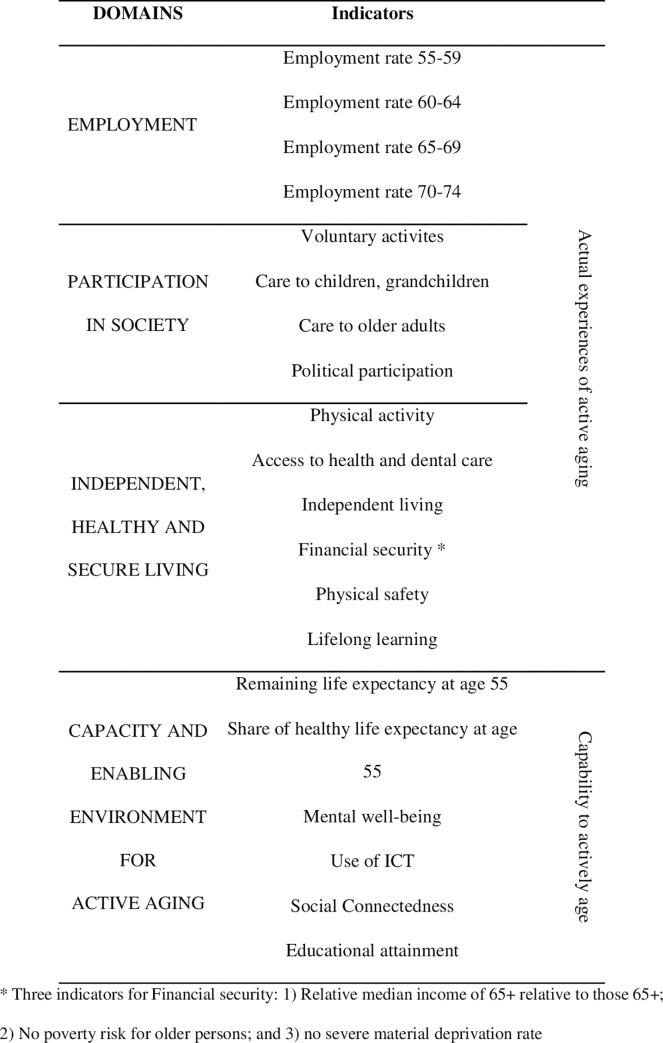
Domains and indicators of Active Aging aggregated index (modified from Zaidi et al. "[48]).